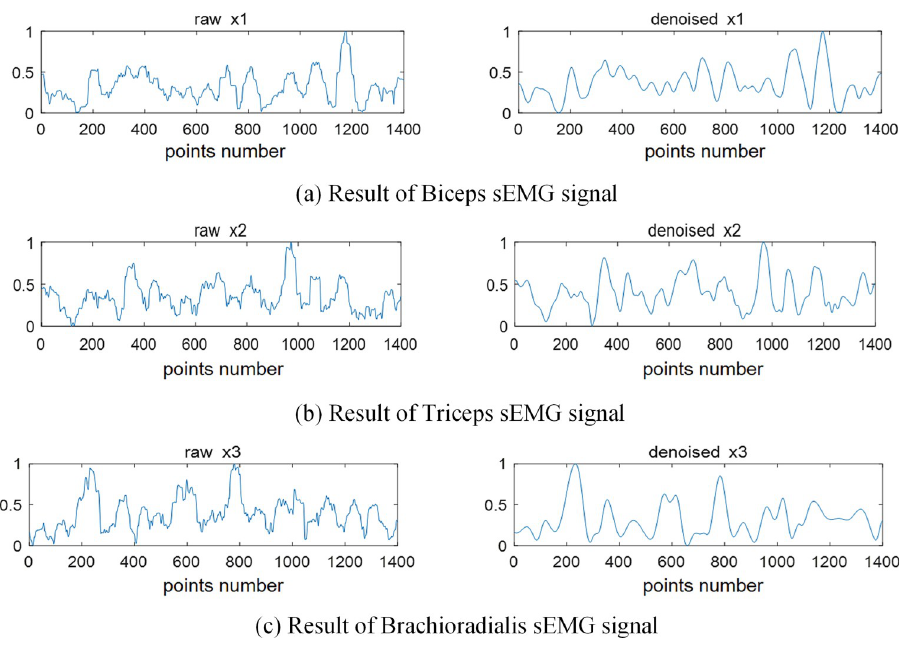
Fig 5. sEMG denoising results. The left side is the synchronous three channels raw sEMG signal, and the right side is the corresponding denoised sEMG signal using the proposed NMFSEMD. Three channels represent (a) biceps brachii signal, (b) triceps brachii signal, and (c) brachioradialis signal.